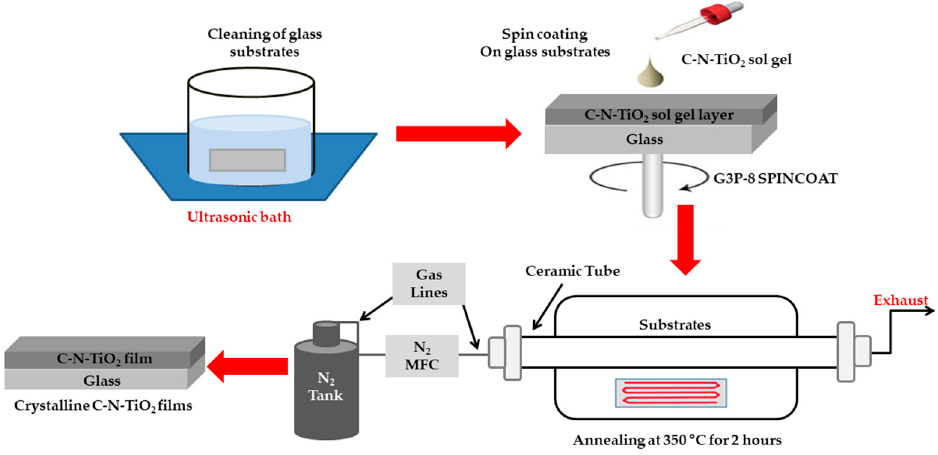
Figure 1. Schematic experimental set up used for spin coating of C-N-TiO 2 thin films.